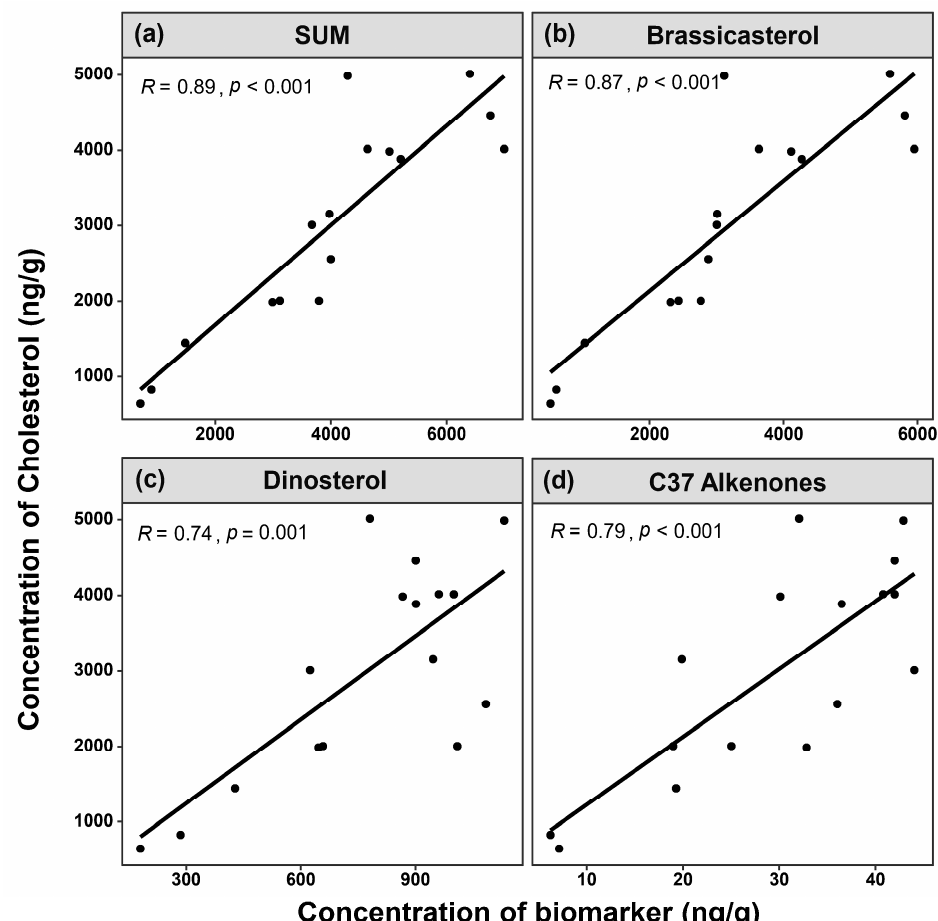
Figure 3. Linear relationship between phytoplankton biomarker and zooplankton biomarker concentrations (SUM = brassicasterol + dinosterol + C37 alkenones).